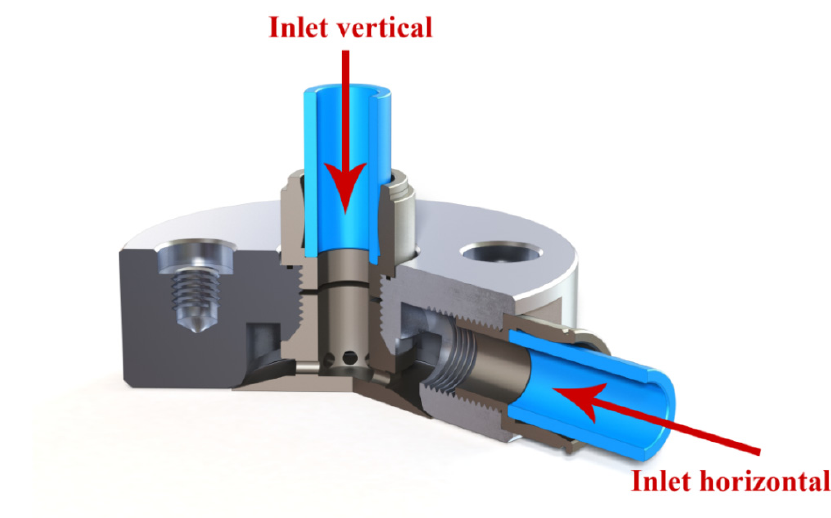
Figure 3. Diagram of compressed air supply directions through BGD chambers.